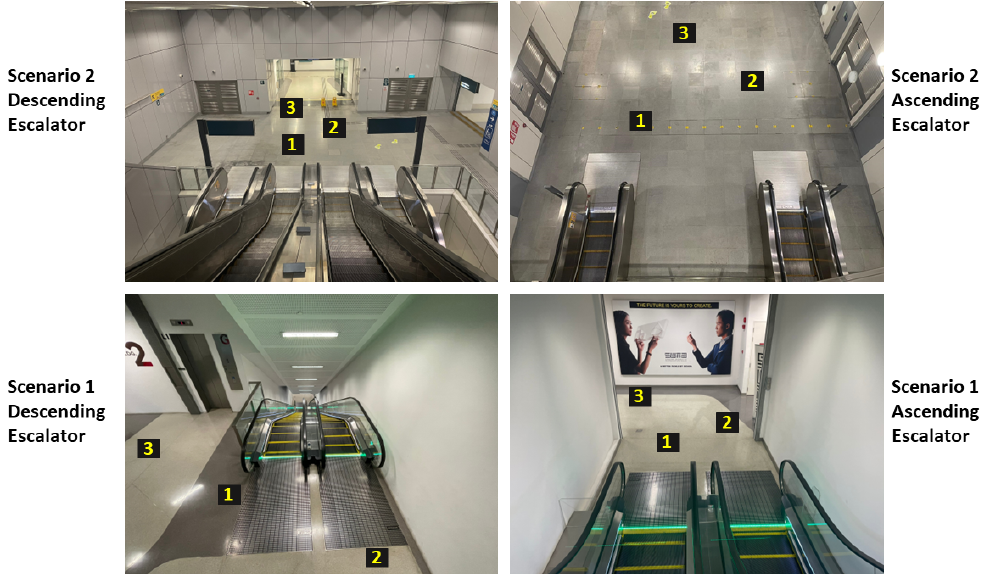
Figure 8. The selected escalator scenarios: Scenario 1 is a semi-outdoor environment considering both descending ( bottom left ) and ascending ( bottom right ) directions; Scenario 2 is an indoor environment considering both ascending ( top right ) and descending ( top left )